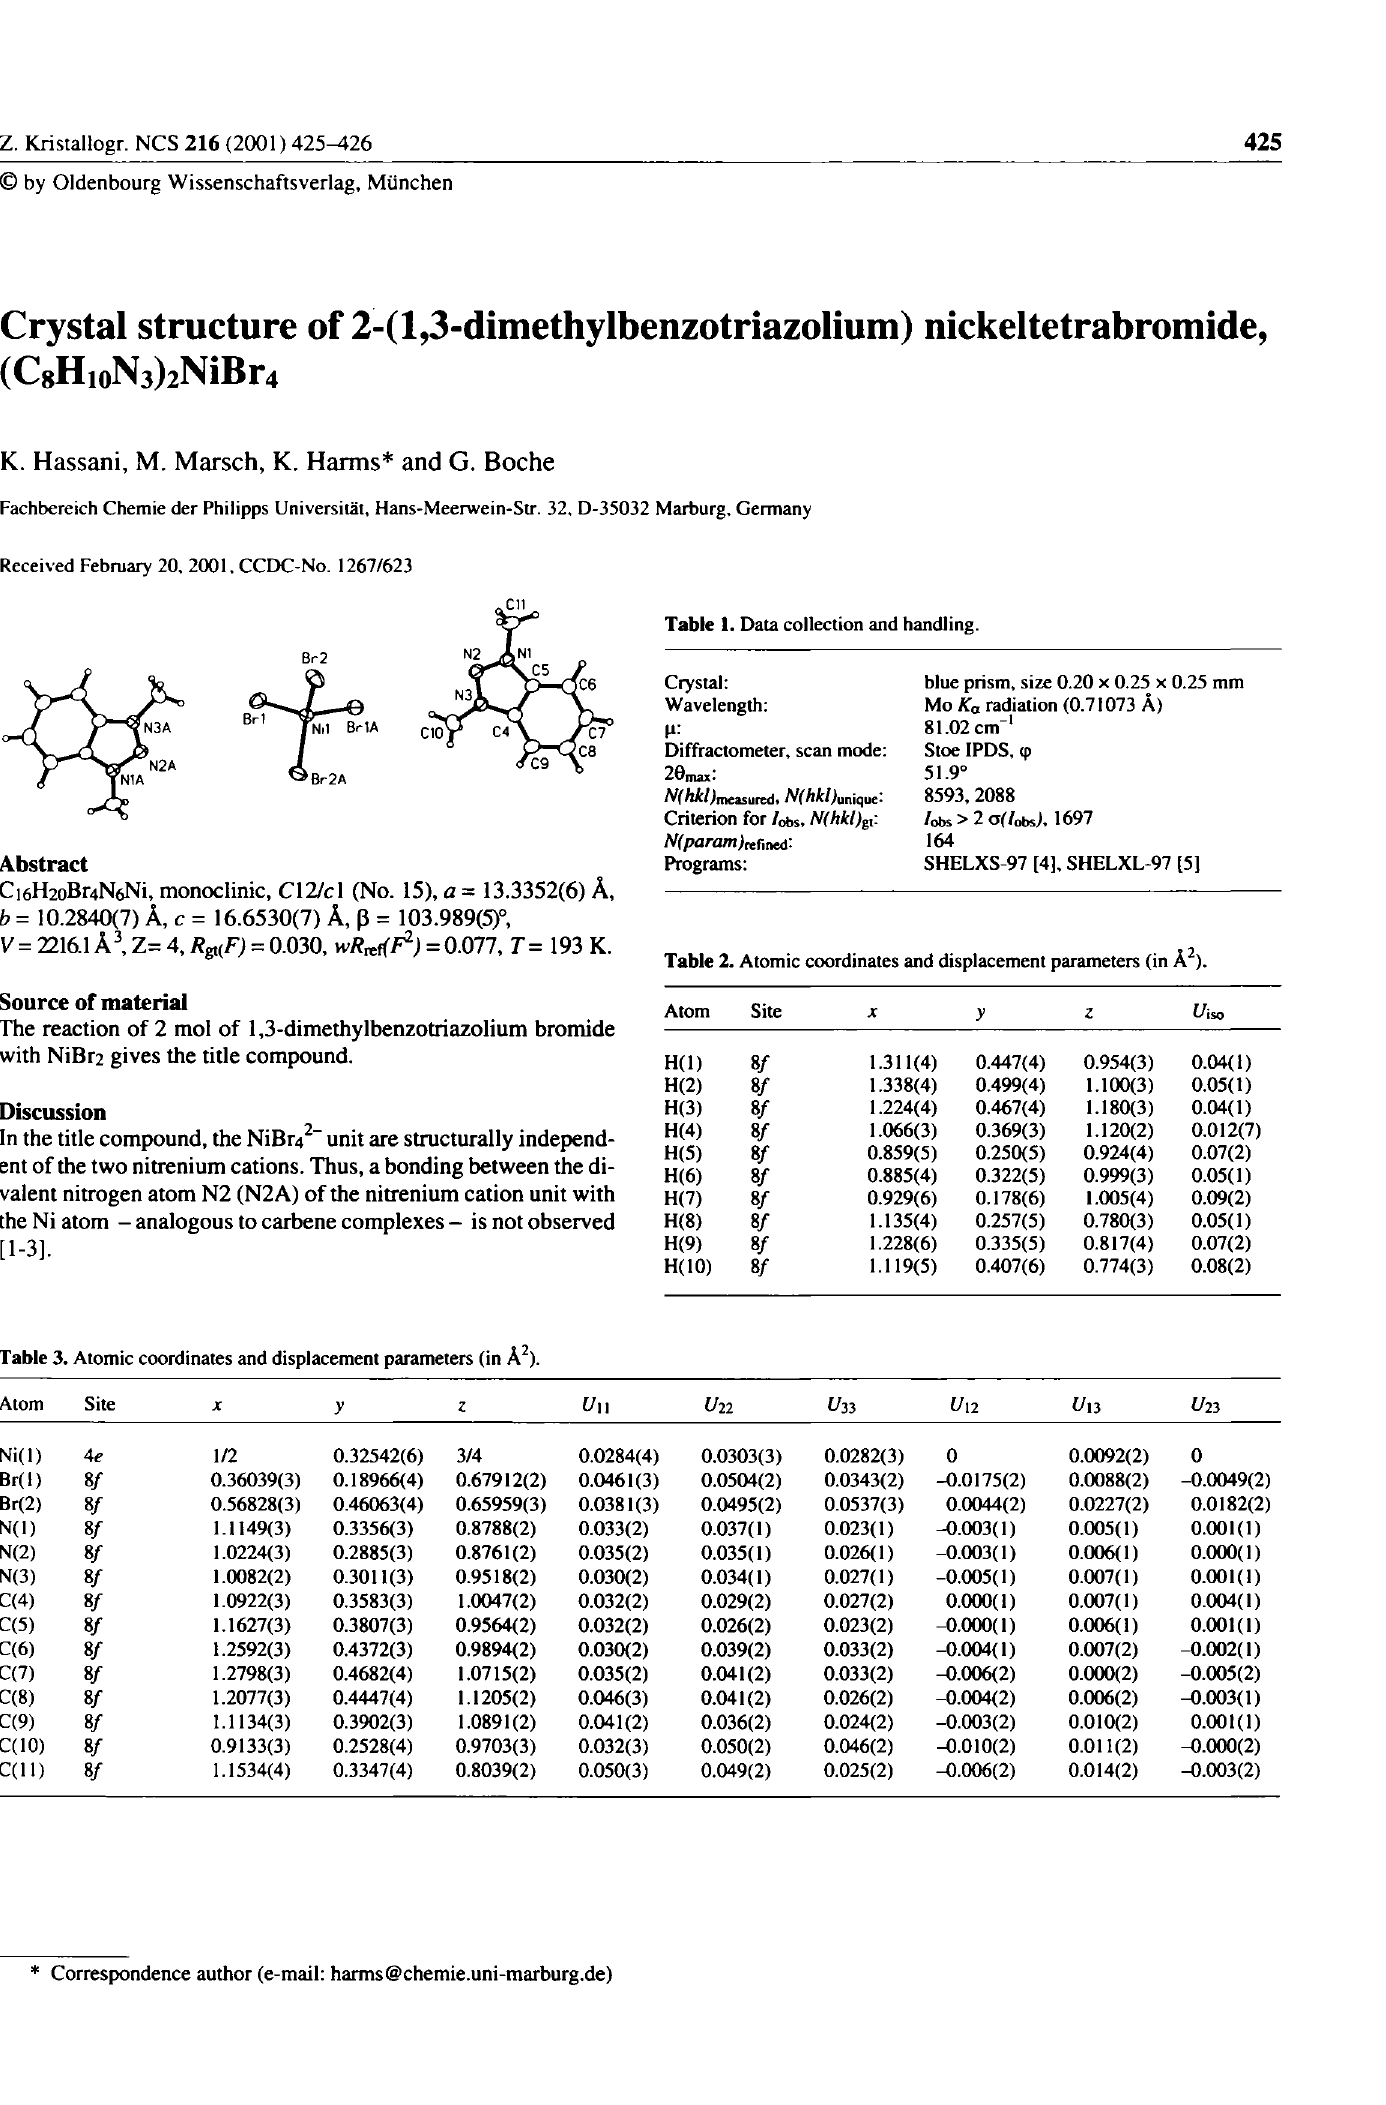
Table 3. Atomic coordinates and displacement parameters (in Ä 2